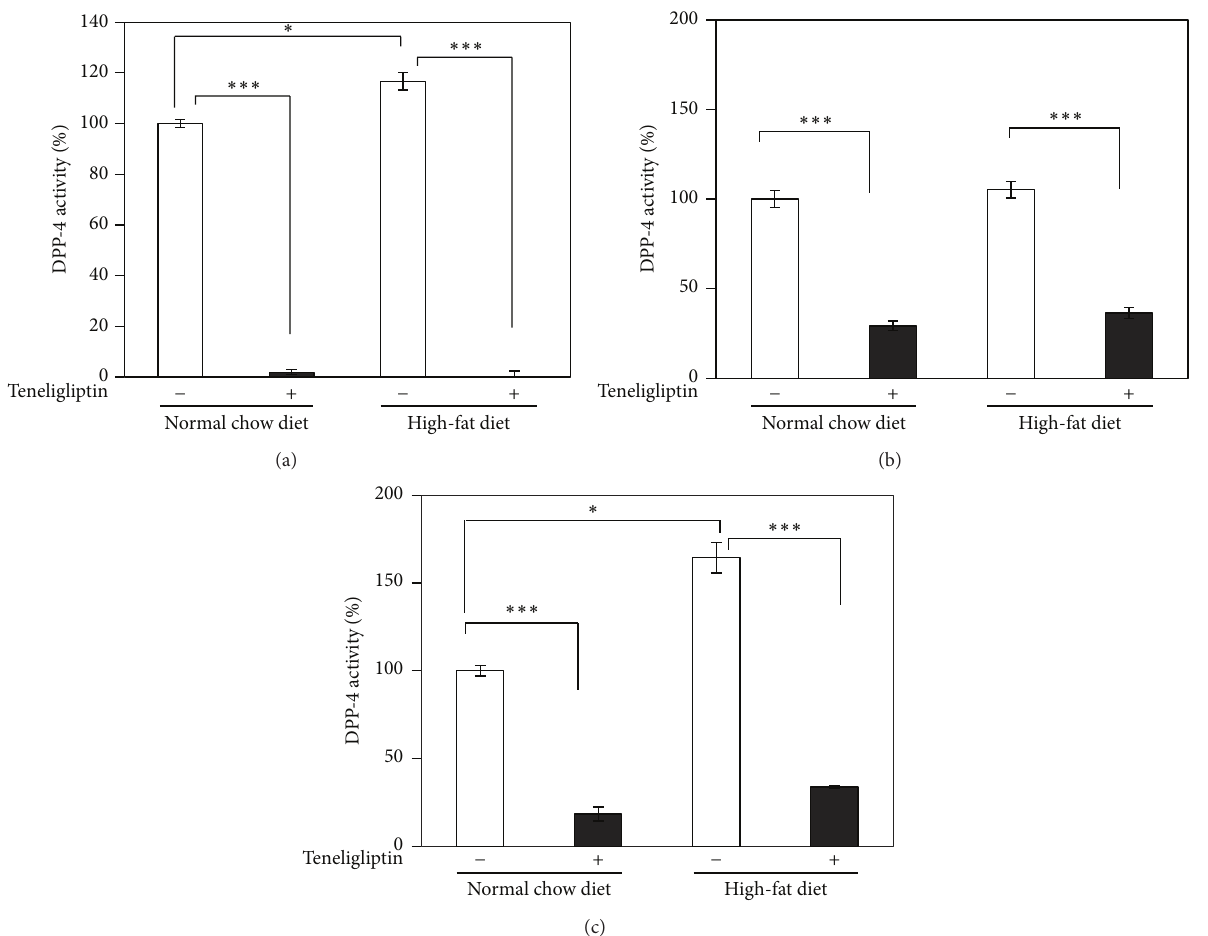
Figure 3: Effects of teneligliptin on DPP-4 activity in plasma (a), liver (b), and epididymal adipose tissues (c) of male Wistar rats. The activity levels of DPP-4 from plasma, liver tissue, and epididymal adipose tissue of the control group (open squares: NCD-fed rats: 𝑛 = 3 , HFD- fed rats: 𝑛 = 3 ) and the teneligliptin group (closed squares: NCD-fed rats: 𝑛 = 4 , HFD-fed rats: 𝑛 = 4 ) were measured by DPP-4 Activity Fluorometric Assay Kit (BioVision Incorporated). Data are the means ± SEM. ∗ 𝑃 < 0.05 versus control rats; ∗∗∗ 𝑃 < 0.001 versus control rats.